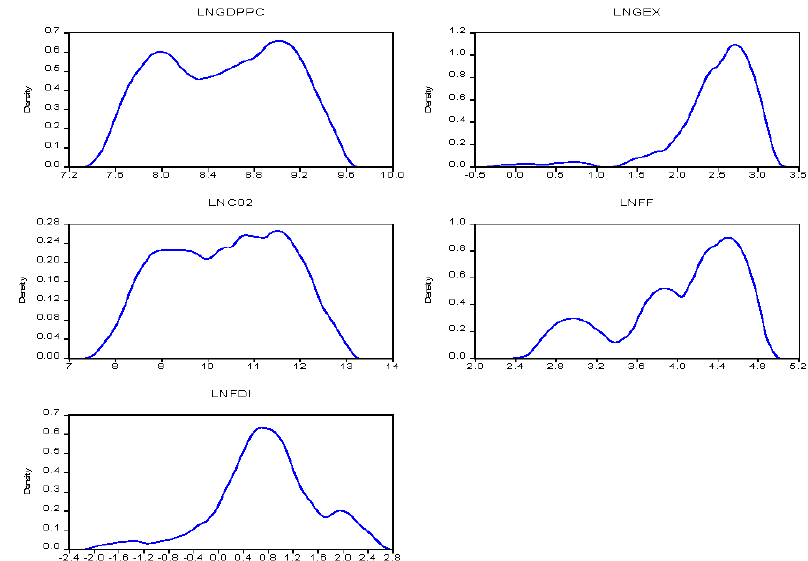
Figure 1. The trend of the indicators-North.